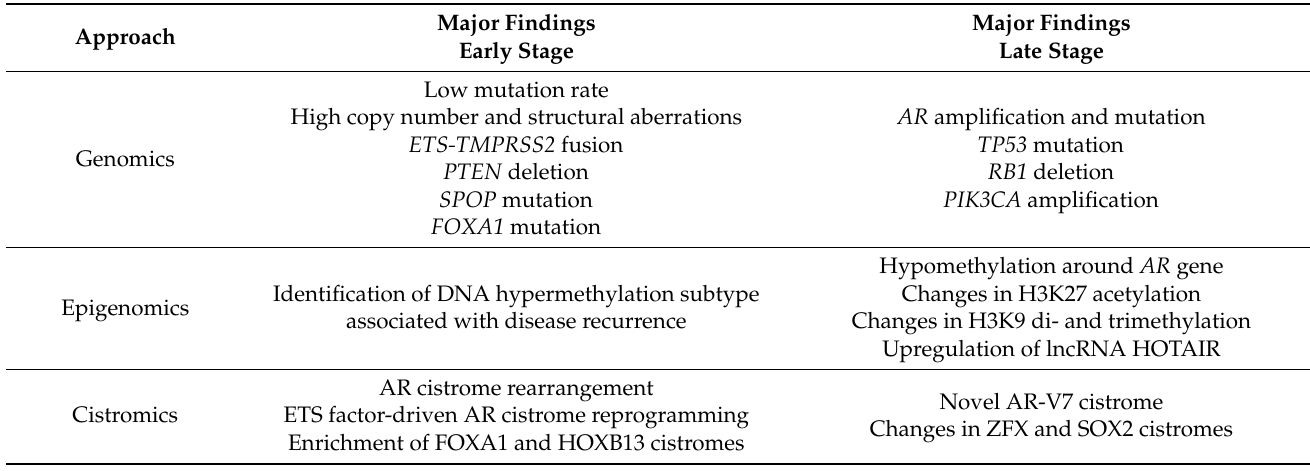
Table 2. Overview of main changes identified in prostate cancer using different omics